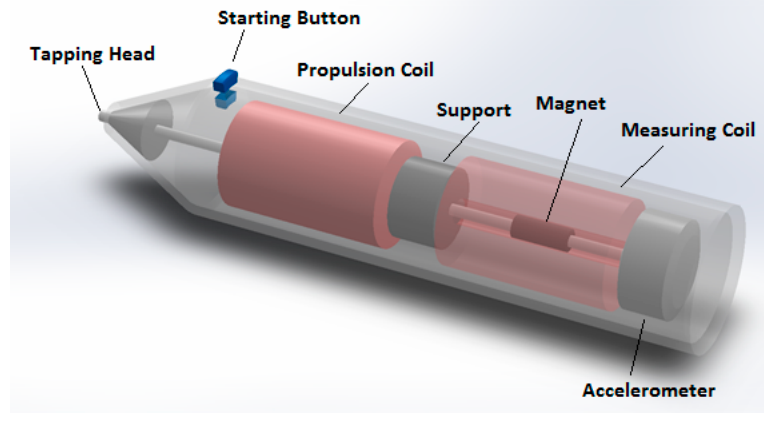
Figure 2. The Periotest probe.